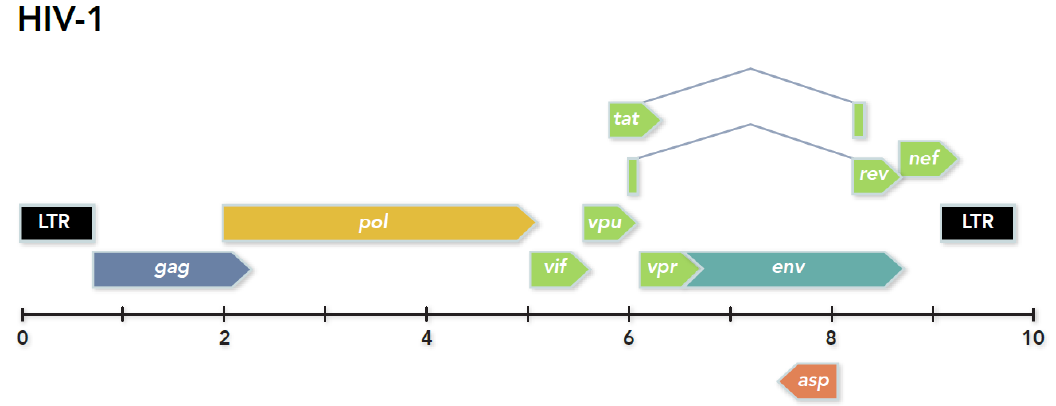
Figure 2. Organization of the HIV-1 Group M genome.